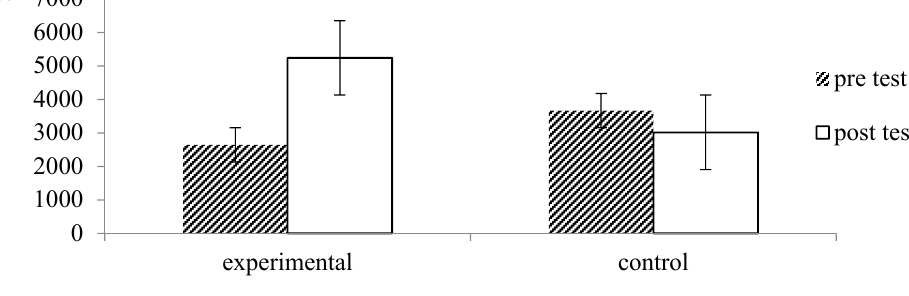
Figure 3. Effect of forest therapy on TP.